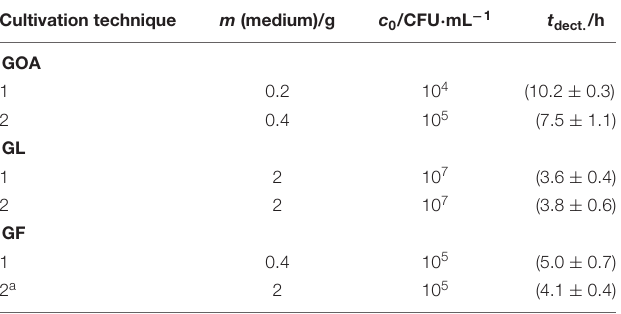
TABLE 3 | Summary of the reproducibility measurements of the different cultivation techniques combined with IMC measurments. Cultivation